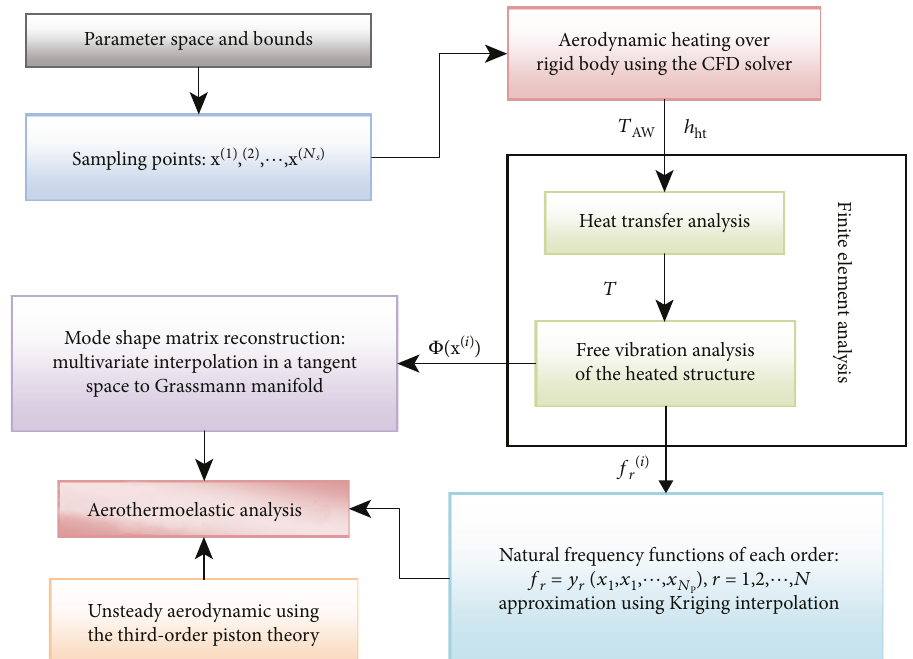
Figure 1: Schematic overview of the aerothermoelastic framework.